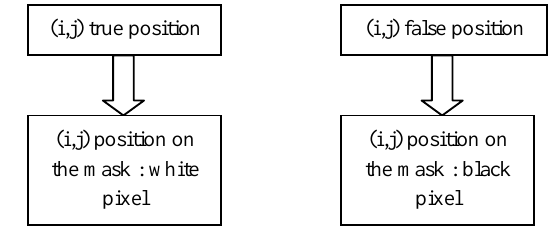
Figure 12: Interpretation of true and false positions for